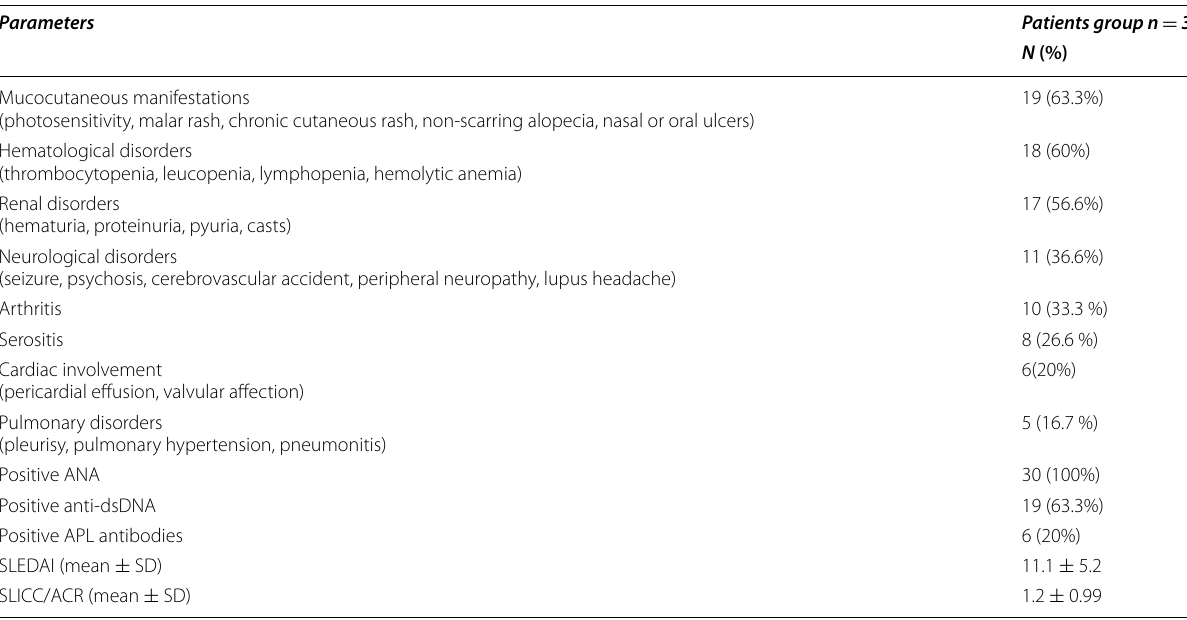
Table 1 Clinical and laboratory data of SLE